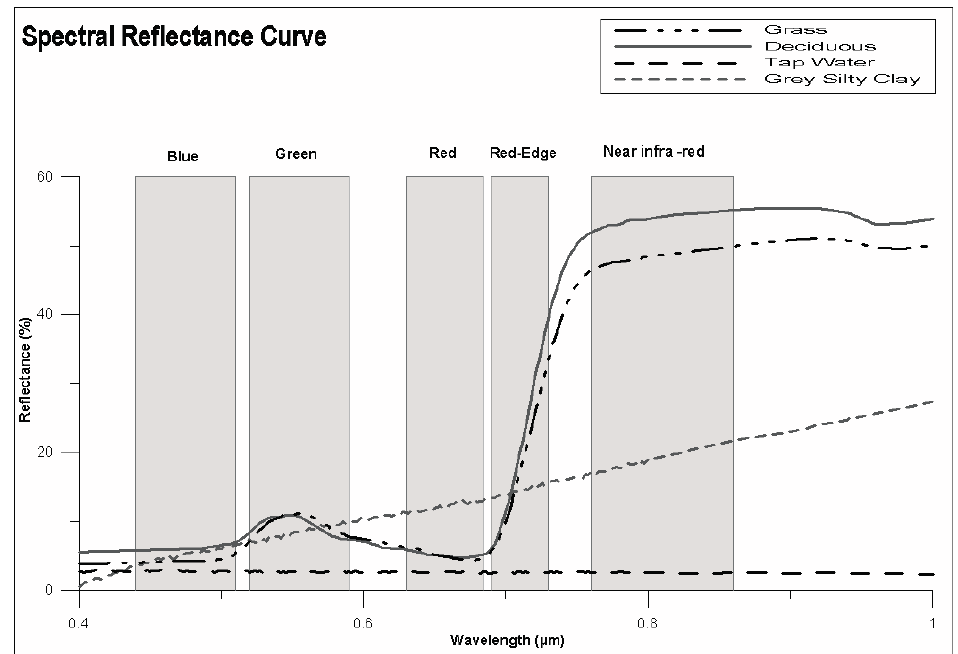
Figure 2. Spectral Reflectance Curves for various features of the land surface plotted against different RapidEye’s spectral channels. Vertical bars represent spectral bands of the RapidEye imagery. (Source for the reflectance data is ASTER Spectral Library).